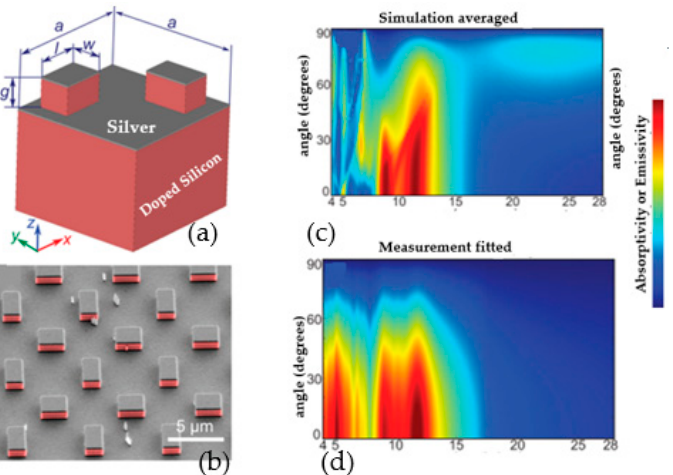
Figure 19. ( a ) DPRC metasurfaces unit cell, with the following measurements: a = 6.9 µ m, l = 2.3 µ m, w = 1.55 µ m, and g = 1.5 µ m. Silver-coated layer is 100 nm ( b ) Fabricated sample (SEM image) ( c ) The simulation’s result calculated mathematically by averaging the simulated absorptivities ( d ) The angular-dependent absorptivity calculated by fitting the measured results [68].